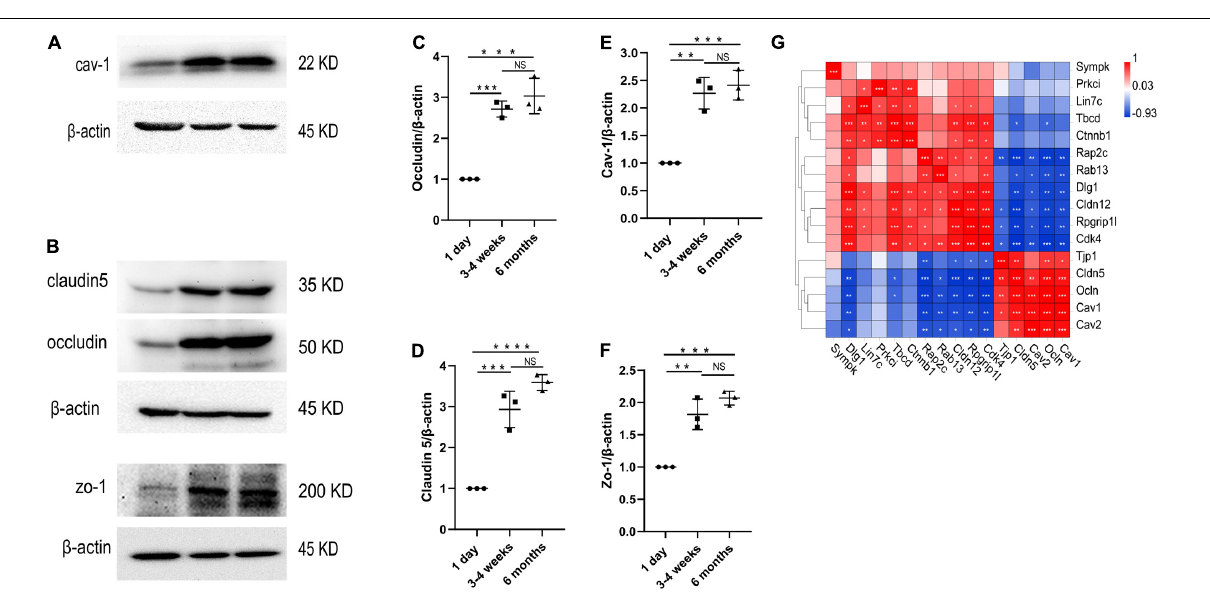
Frontiers in Neuroscience |